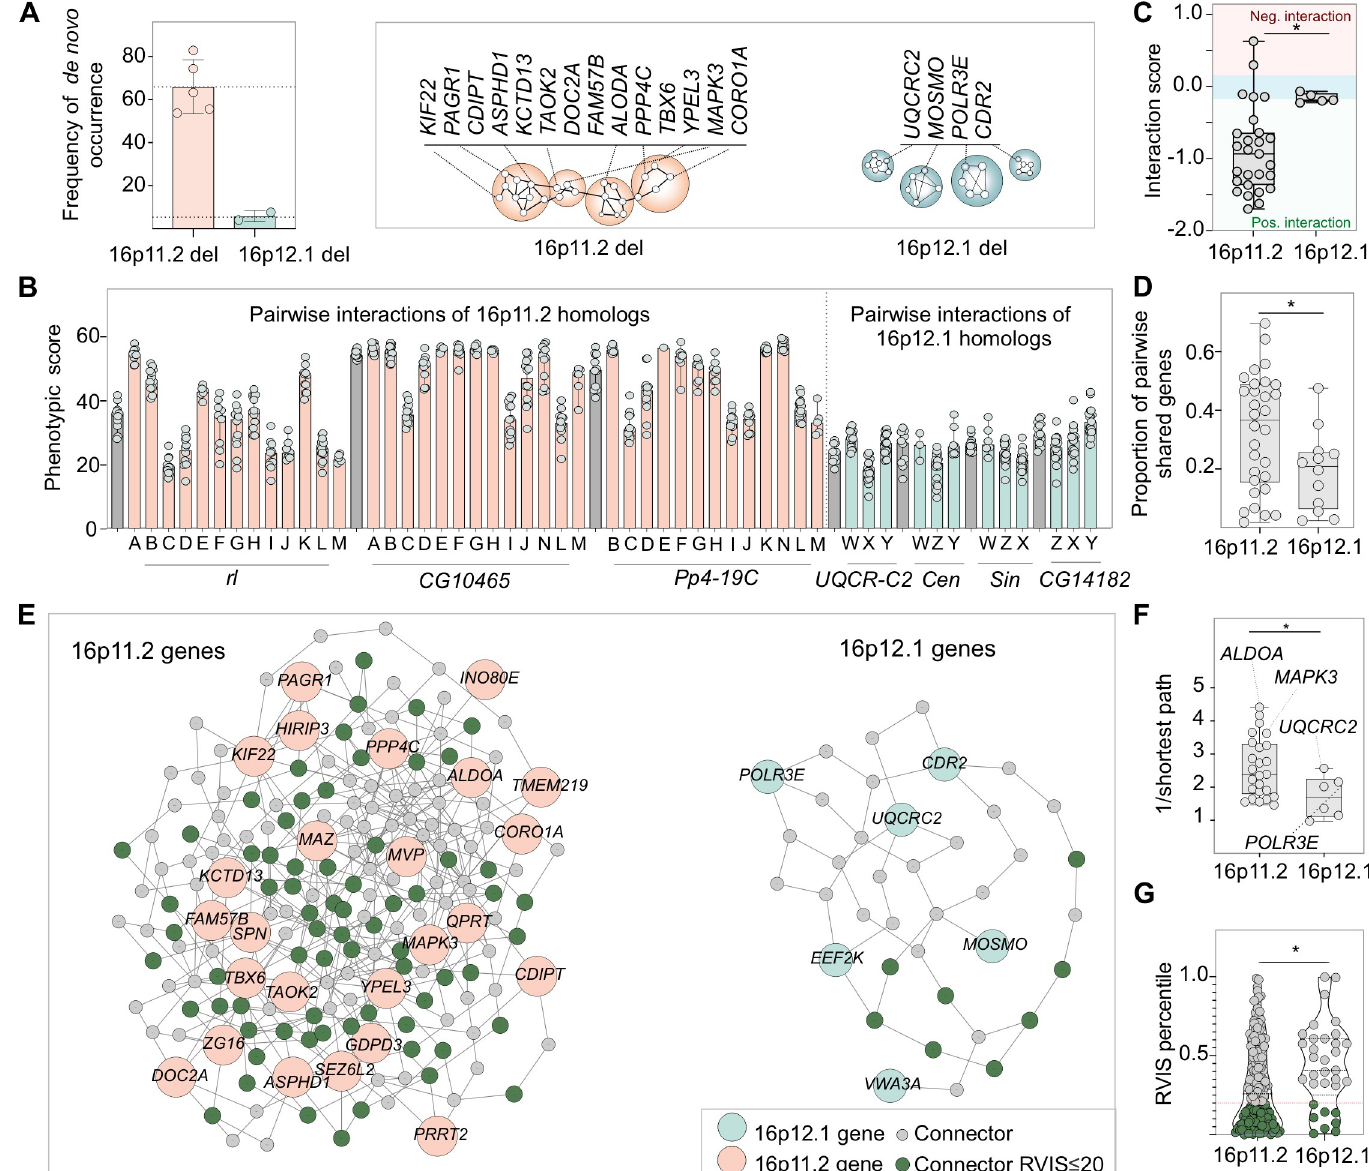
Fig 7. Functional relatedness of genes within disease-associated CNV regions correspond with higher pathogenicity. ( A ) Bar plot shows frequency of reported de novo occurrence of the 16p12.1 deletion [9,11] compared to the autism-associated 16p11.2 deletion [11,74,75].Schematic shows a model for higher functional connectivity of genes within the 16p11.2 region compared to the 16p12.1 region. Only genes with Drosophila homologs are represented. ( B ) Phenotypic scores of individual 16p11.2 homologs (grey) are significantly enhanced or suppressed by a second 16p11.2 homolog (orange). In contrast, little variation in phenotypic scores is observed for 16p12.1 homologs (grey) with simultaneous knockdown of another homolog (green). The interacting homologs are labeled as follows: A: Pp4-19C ( PPP4C ), B: CG17841 ( FAM57B ), C: coro ( CORO1A ), D: Ald1 ( ALDOA ), E: Rph ( DOC2A ), F: Tao ( TAOK2 ), G: Asph ( ASPHD1 ), H: klp68D ( KIF22 ), I: Pa1 ( PAGR1 ), J: Pis ( CDIPT ), K: CG10465 ( KCTD13 ), L: CG15309 ( YPEL3 ), M: Doc3 ( TBX6 ), N: rl ( MAPK3 ), W: CG14182 ( MOSMO ), X: Cen ( CDR2 ), Y: Sin ( POLR3E ), Z: UQCR-C2 ( UQCRC2 ). ( C ) Pairwise knockdown of homologs of 16p11.2 genes (n = 27) show a larger magnitude of interactions compared with those among 16p12.1 homologs (n = 5, two-tailed Mann-Whitney test, � p = 0.011). Interaction values of zero (blue shade) represent no interactions, while values above or below zero represent negative (in red) and positive (in green) interactions, respectively. ( D ) Pairs of 16p11.2 homologs exhibit a higher proportion of shared differentially-expressed genes compared to pairs of 16p12.1 homologs (n = 30 for 16p11.2, n = 12 for 16p12.1, two-tailed Mann-Whitney test, � p = 0.031). ( E ) Network diagram shows connections between human 16p11.2 or 16p12.1 genes within a brain-specific interaction network. 16p12.1 genes are indicated in green, 16p11.2 genes in orange, connector genes in grey, and connector genes that are intolerant to functional variation (RVIS � 20 th percentile) in dark green. C16orf92 and C16orf54 for 16p11.2 and PDZD9 for 16p12.1 were not present in the brain network and were therefore excluded from the network analysis. ( F ) Genes within the 16p11.2 region show higher average pairwise connectivity in a human brain-specific network, measured as the inverse of the shortest paths between two genes, compared to 16p12.1 genes (n = 25 for 16p11.2, n = 6 for 16p12.1, two-tailed Mann-Whitney, � p = 0.036, see S5 File ). ( G ) 16p11.2 connector genes have lower RVIS percentile scores compared to 16p12.1 connector genes (n = 166 for 16p11.2, n = 33 for 16p12.1,